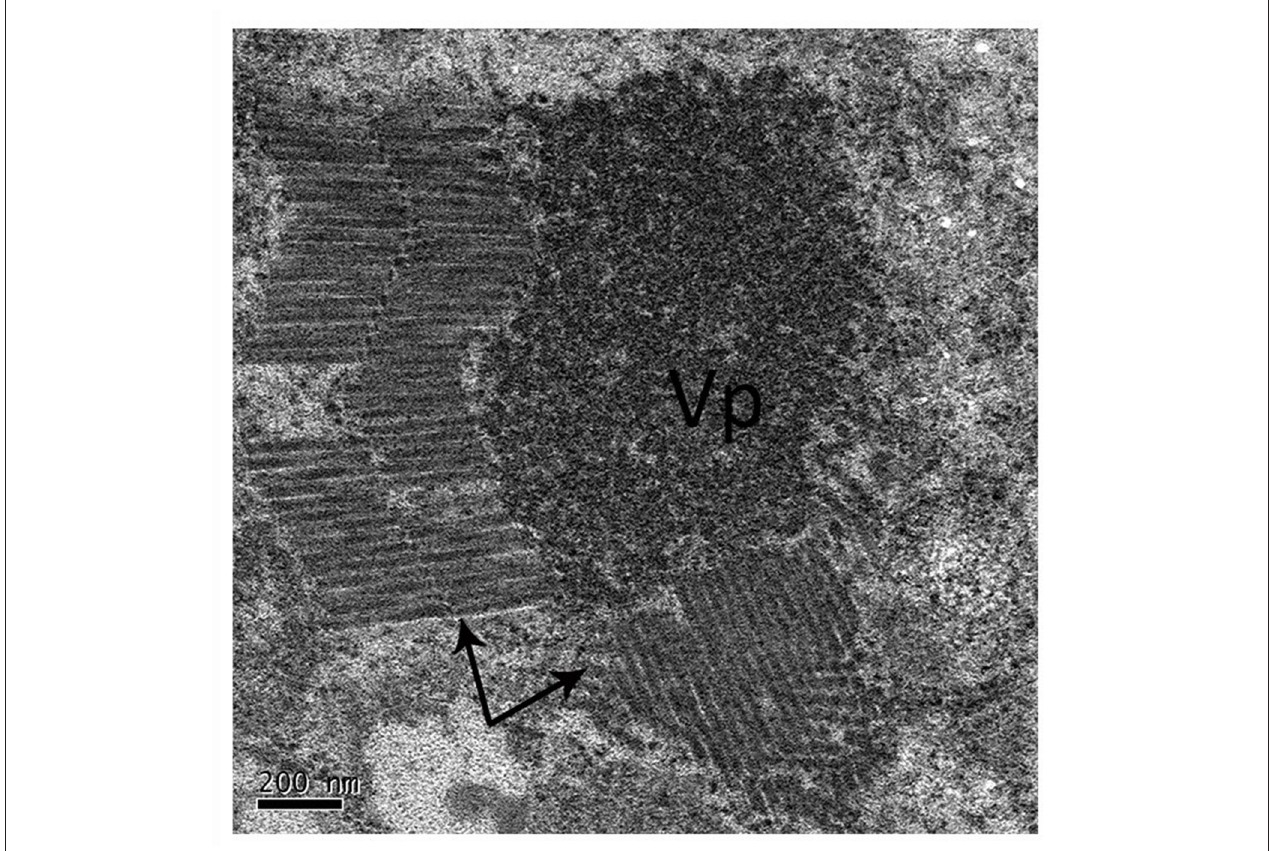
FIGURE 1 | Electron microscopy of RSMV in the midgut of R. dorsalis . Midgut tissues of viruliferous R. dorsalis adults were dissected and negative-stained. RSMV virions were observed using a transmission electron microscope. “VP”: viroplasm; black arrows: RSMV